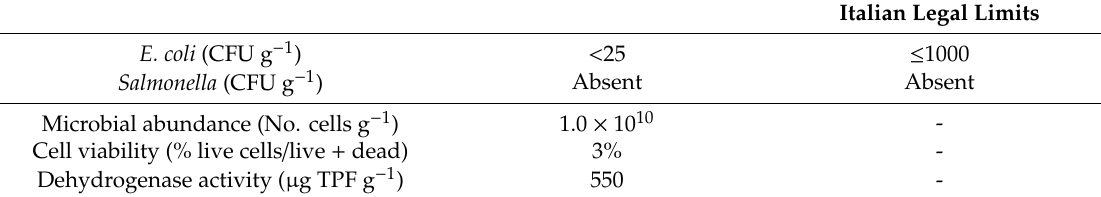
Figure 1. Location of the sampling site overlooking the Little Sea of Taranto. Table 1. Municipal solid waste compost: microbiological parameters analysed in accordance with the legislation for fertilizers (Italian Decree 75 / 2010) for pathogens ( E. coli and Salmonella ) and additional ones (Microbial abundance, Cell viability and Dehydrogenase activity) assessed for its initial characterization before the addition to soil microcosms.